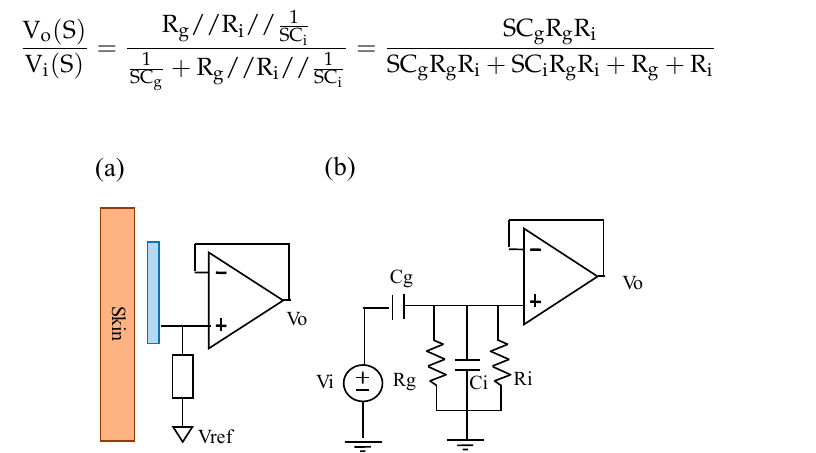
Figure 1. The skin-electrode interface models of ( a ) an Ag–AgCl electrode and ( b ) a noncontact dry electrode.